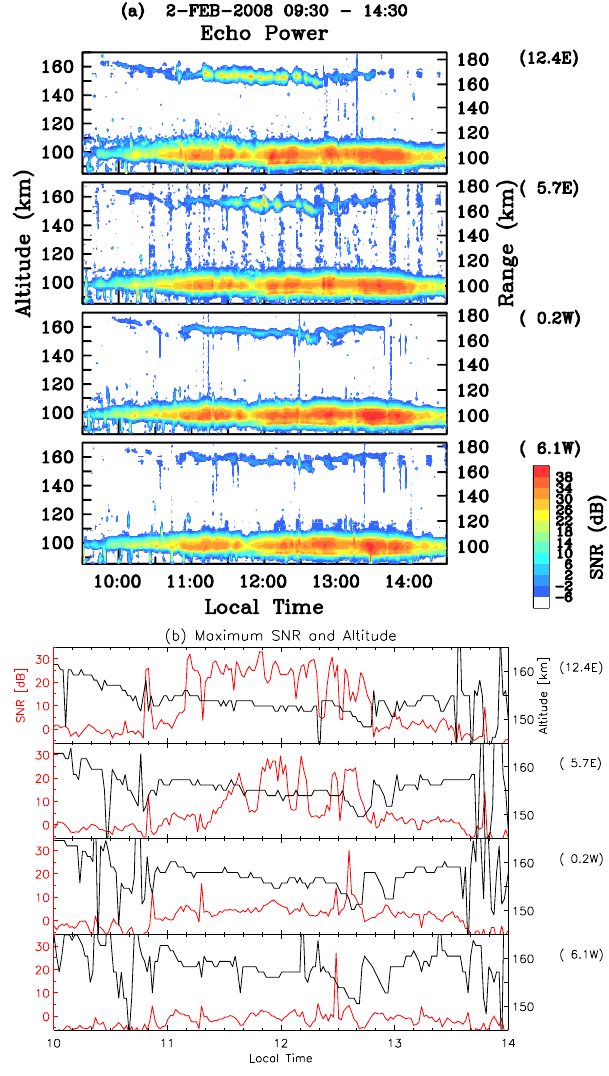
Fig. 2. (a) Range-time-intensity (RTI) plots of signal-to-noise ratio (SNR) of the backscatter echoes obtained by the high resolution mode on 2 February 2008. (b) Time variation of the maximum SNR and altitude of 150-km echoes.